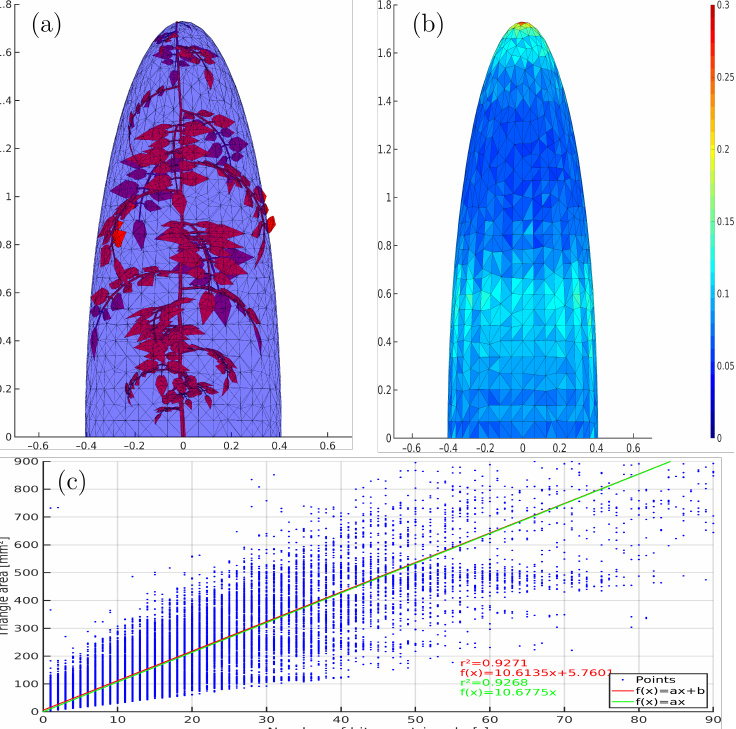
Figure 7. Visualization of the surrounding half ellipsoid ( a ), that is used to estimate the relation between triangle area and number of hits. As shown in ( b ) the hit density per square millimeter triangle area [hit/mm 2 ] is quite homogenise around the surface of the ellipsoid with a slight higher concentration on the north pole and a bit lower at the south pole as expected from the used geometry from the hemispherical shape of the scanner dome. The chart in ( c ) shows the relation between the number of hits per triangle versus the area of